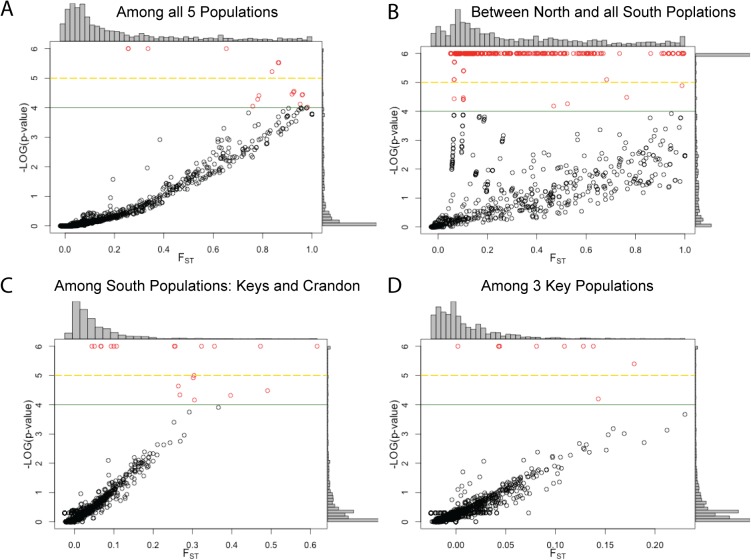
FST values and p-values for all SNPs.SNPs shown as a function of their FST values and their corresponding FDR corrected P-value. Histograms show the distribution FST values (above) and p-values (right) of plot. FDist2 outlier SNPs are shown in Red above the green line. SNPs above the yellow dashed line have p-values below the Bonferroni’s correction threshold (< 10−5). Comparisons shown A: All 5 populations, B: North vs. South Florida (Crandon and the Keys as one population), C: South Florida (Crandon versus the Keys), D: Keys (BPC, BPN, NNK). SNPs with a p-value < 1E-6 were set to 1E-6.